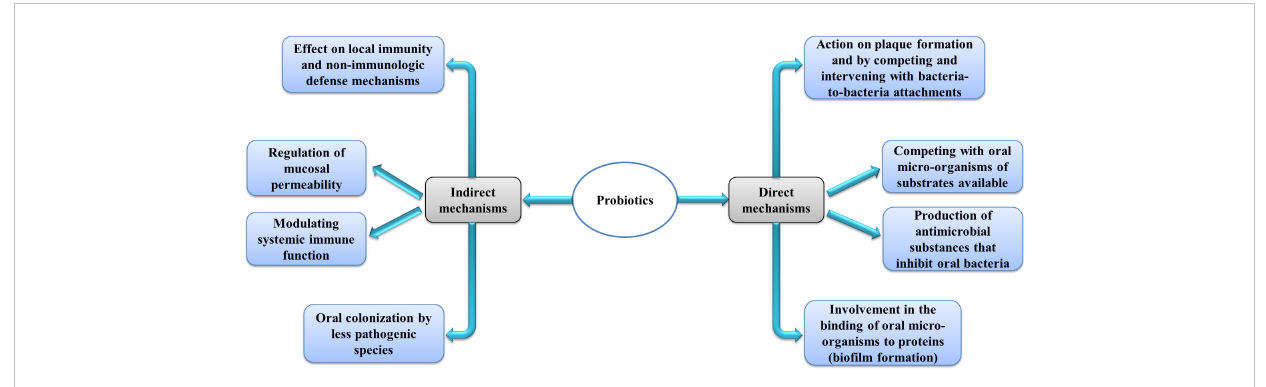
FIGURE 1 Possible mechanisms of probiotic in the oral